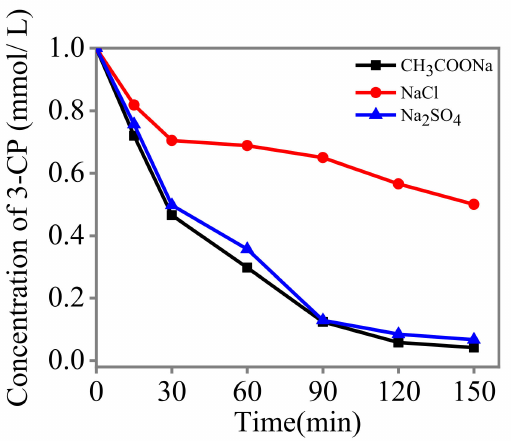
Figure 10. Effect of different electrolytes on the variation of the 3-CP